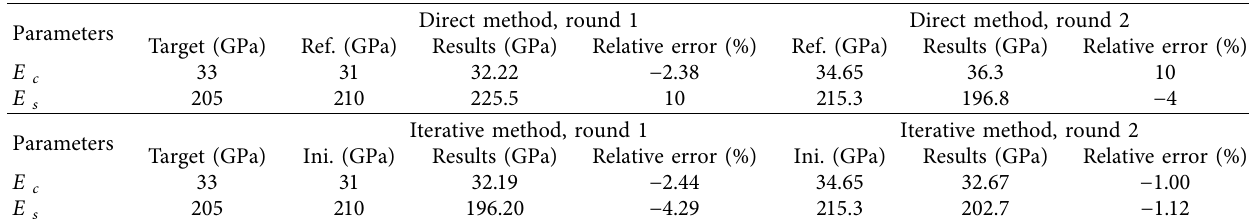
Table 6: Target values, reference/initial values, and updated values by the different